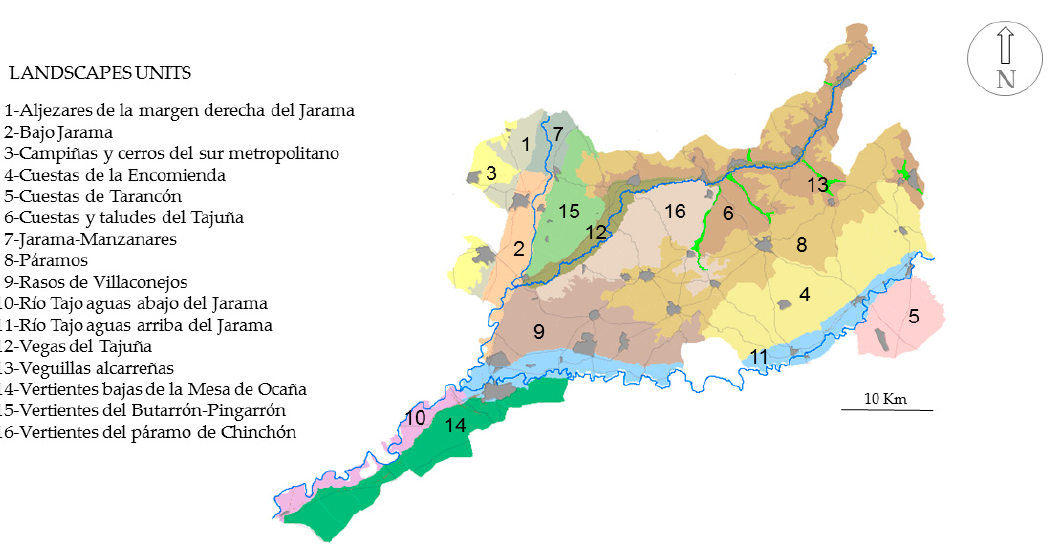
Figure 3 . Landscape units of the Comarca de las Vegas. Source: based on criteria established by Mata, R. (Coord.) et al. [47].